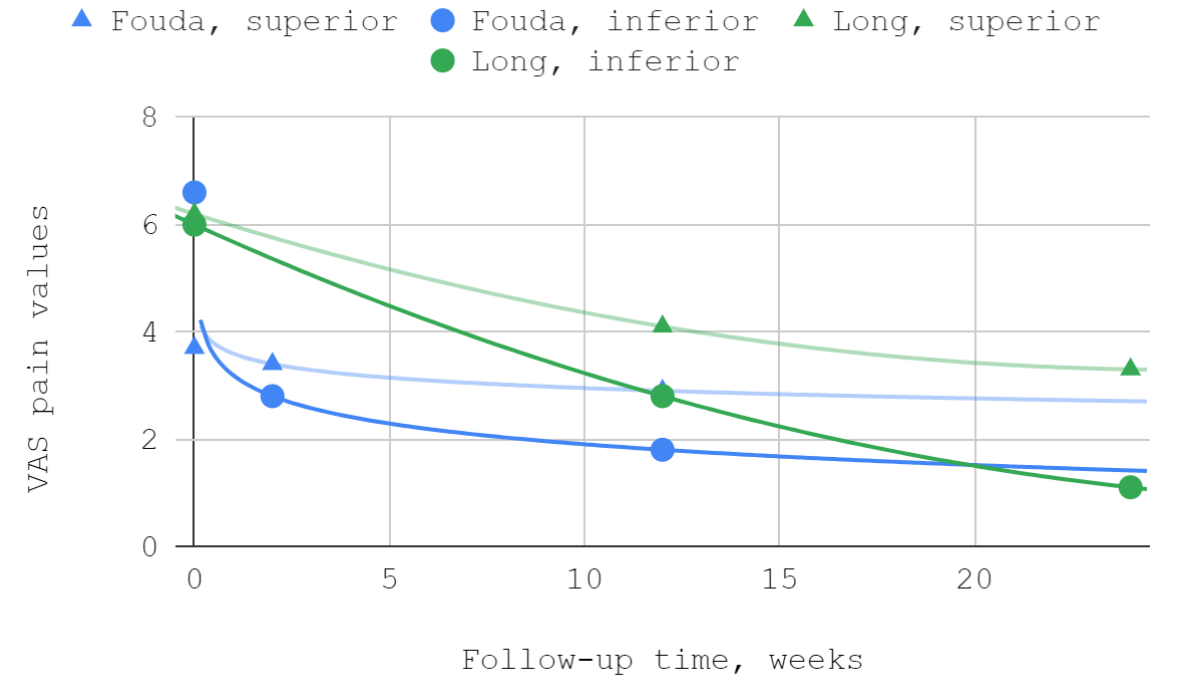
Figure 3. Articular pain in VAS over time.